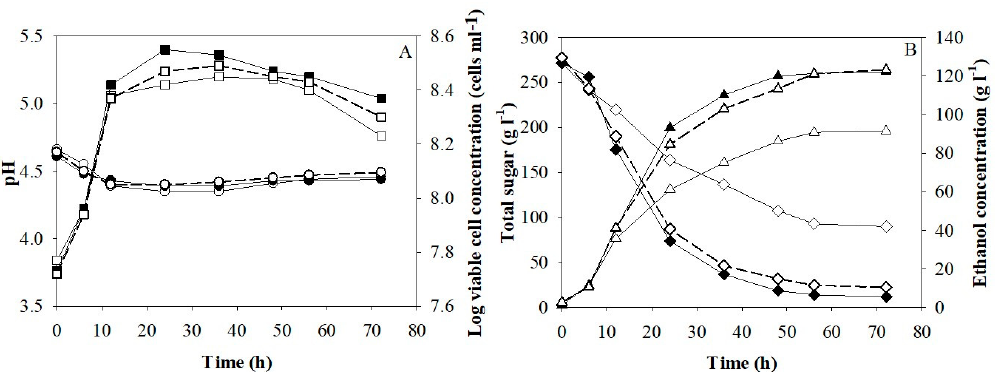
Figure4. Ethanolfermentationin2-Lfermenterfromthesweetsorghumjuicewithnutrientsupplements Figure 4. Ethanol fermentation in 2-L fermenter from the sweet sorghum juice with nutrient at the optimal concentrations (yeast extract, 3; DSY, 4, and glycine, 5 g / L) (closed symbols, solid lines), supplements at the optimal concentrations (yeast extract, 3; DSY, 4, and glycine, 5 g/L) (closed without nutrient supplements (open symbols, solid lines), and with 9 g / L of yeast extract (open symbols, symbols, solid lines), without nutrient supplements (open symbols, solid lines), and with 9 g/L of dashed lines). ( A ) pH ( (cid:8) ) and log viable cells (cells / mL, (cid:4)(cid:3) ) and ( B ) total sugar (g / L, (cid:7)♦ ) and ethanol yeast extract (open symbols, dashed lines). A: pH (  ) and log viable cells (cells/mL,  ) and B: (cid:35) (g / L, (cid:78) (cid:52) total sugar (g/L,  ) and ethanol (g/L,  ).